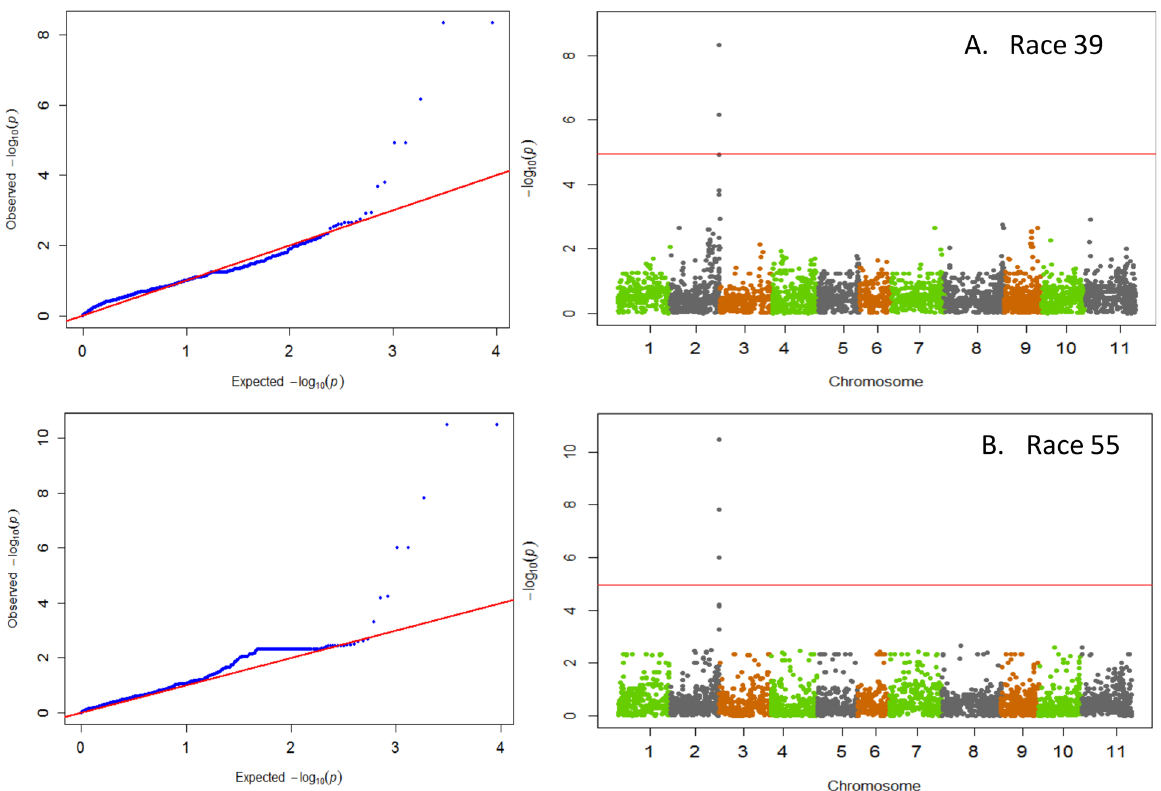
Fig 2. QQ and Manhattan Plots showing candidate SNPs and P-values from GWAS using MLM for anthracnose resistance. From top to bottom include results for anthracnose resistance to A) race 39 and B) race 55 on Pv02. Red line on Manhattan Plots is the significance threshold of P = 1.03 x 10 − 5 after Bonferonni correction of α =